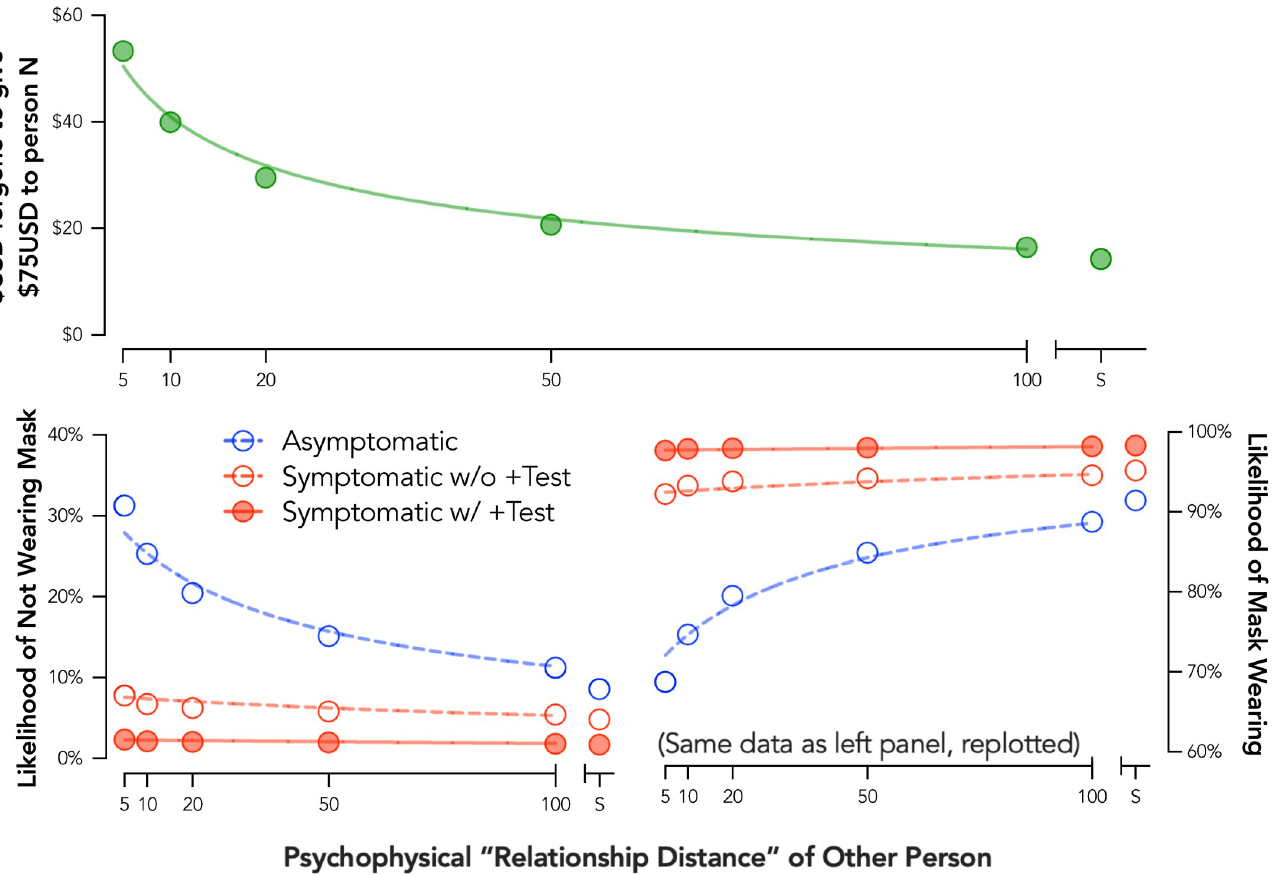
Fig 3. Social discounting for facemask use and monetary outcomes. Plotted are group discounting curves for money (top panel) and facemask use (bottom panels). Three facemask use conditions are presented: asymptomatic (red open circles, dotted line), was symptomatic without a COVID-19 test (red open circles, dotted line), and 3) was symptomatic with a positive COVID-19 test (red closed circles, solid line). Curves are plotted using the hyperbolic discounting equation including a non-linear scaling parameter [43]. S = stranger.